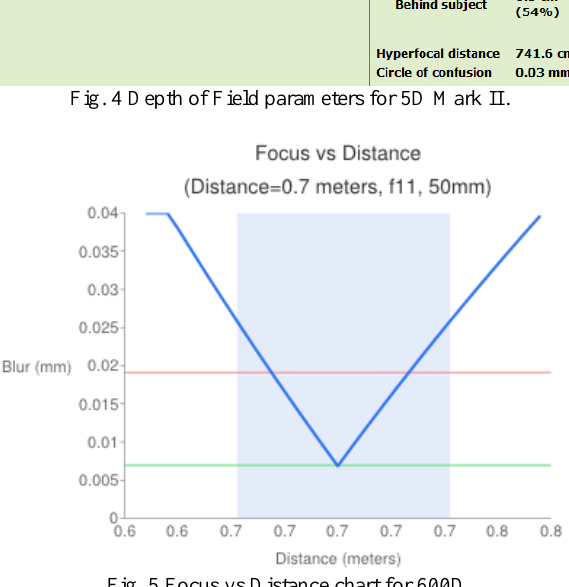
Fig. 5 Focus vs Distance chart for 600D.